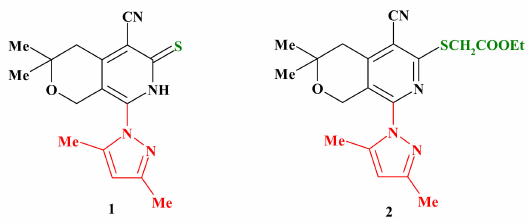
Figure 1. The structure of starting pyrazol-1-yl-substituted thioxopyrano[3,4- c ]pyridine 1 and ethyl thioacetatepyrano[3,4- c ]pyridine 2